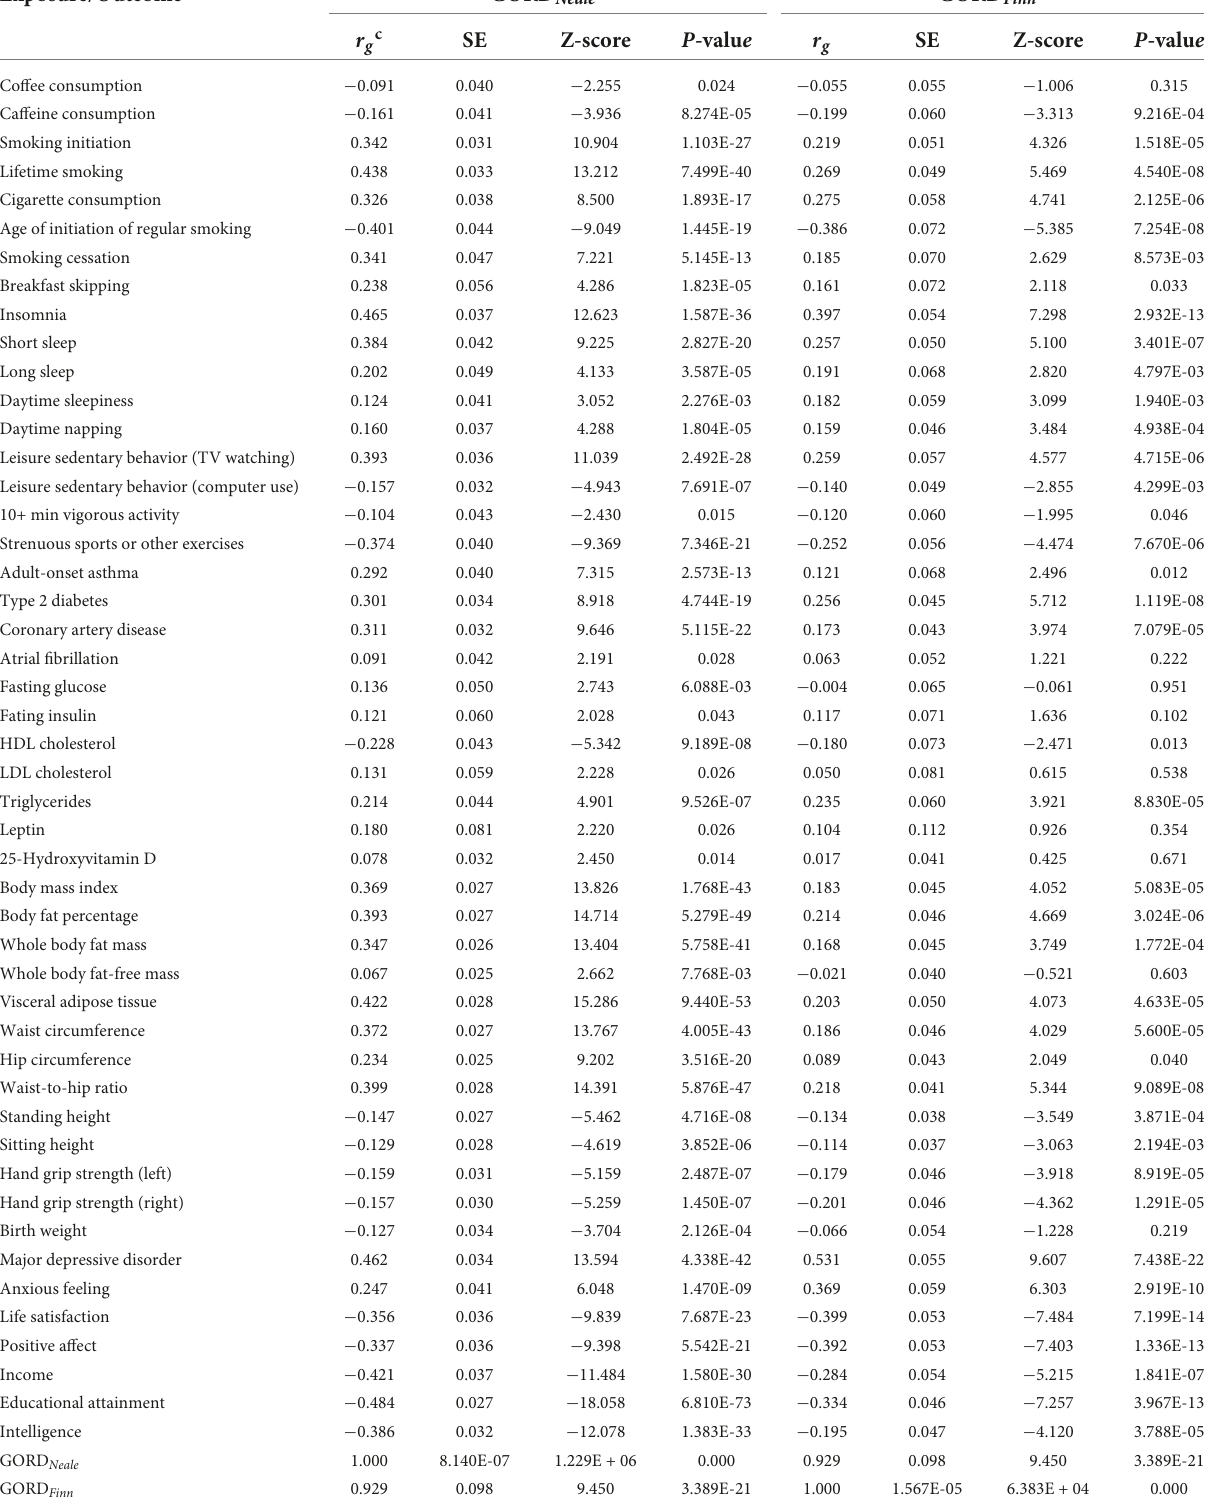
TABLE 2 Statistically significant genetic correlation between 48 exposures and GORD Neale as well as GORD Finn . Exposure/Outcome GORD Neale a GORD Finn